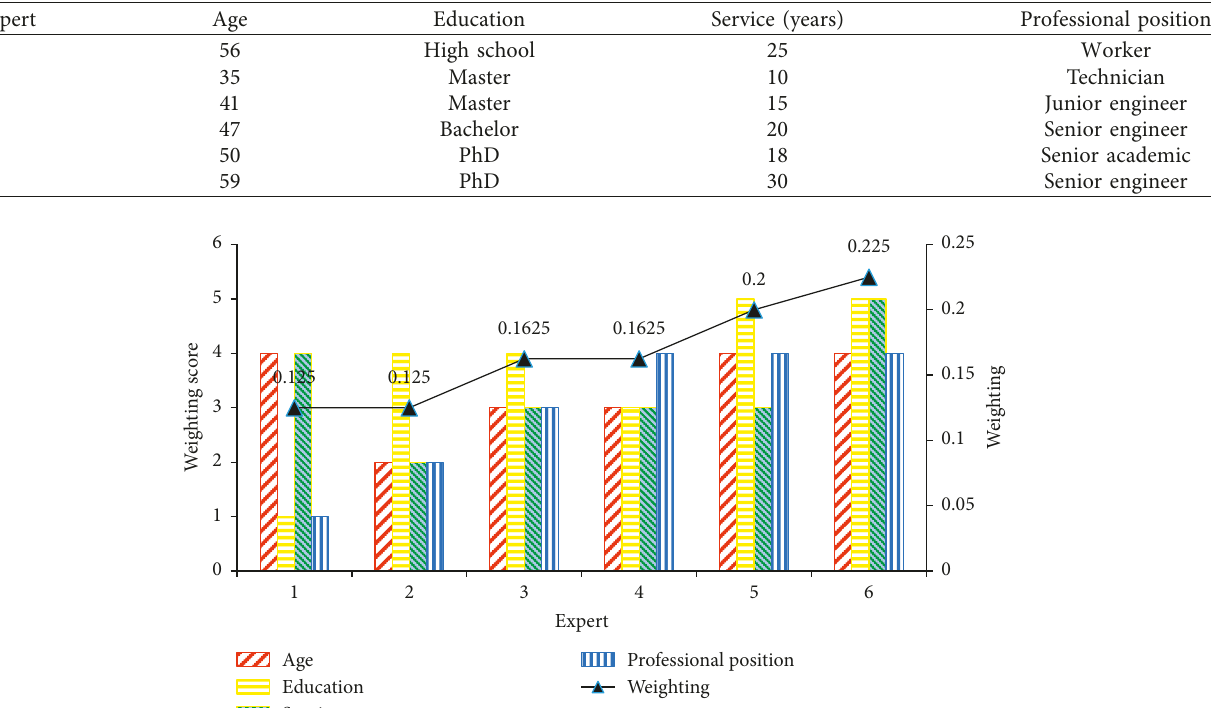
Figure 11: Distribution of each expert opinion weight.